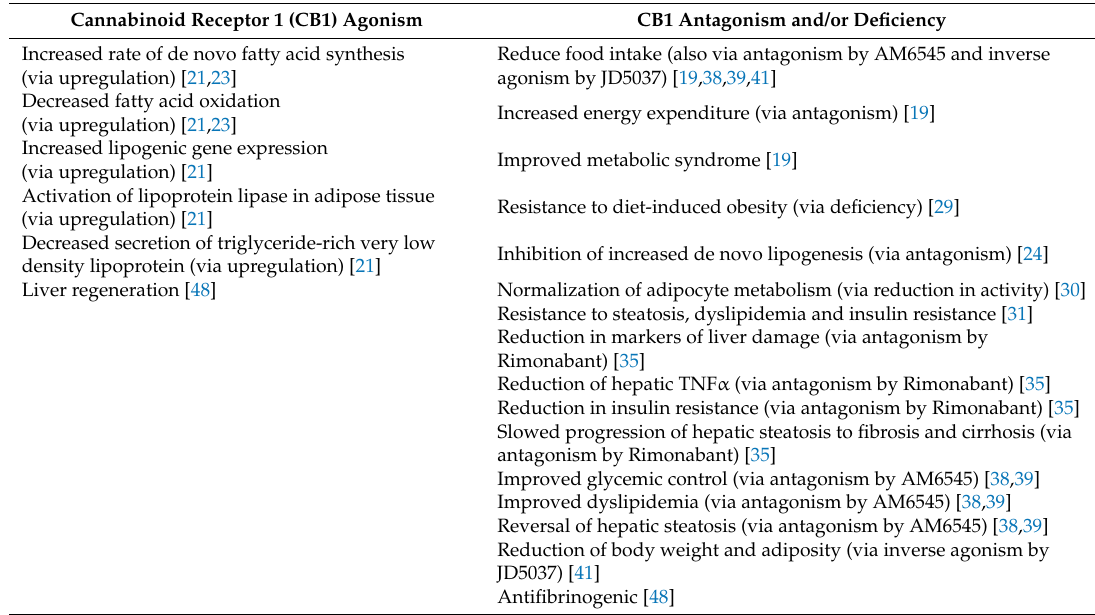
Table 2. Agonism and Antagonism and/or Deficiency of